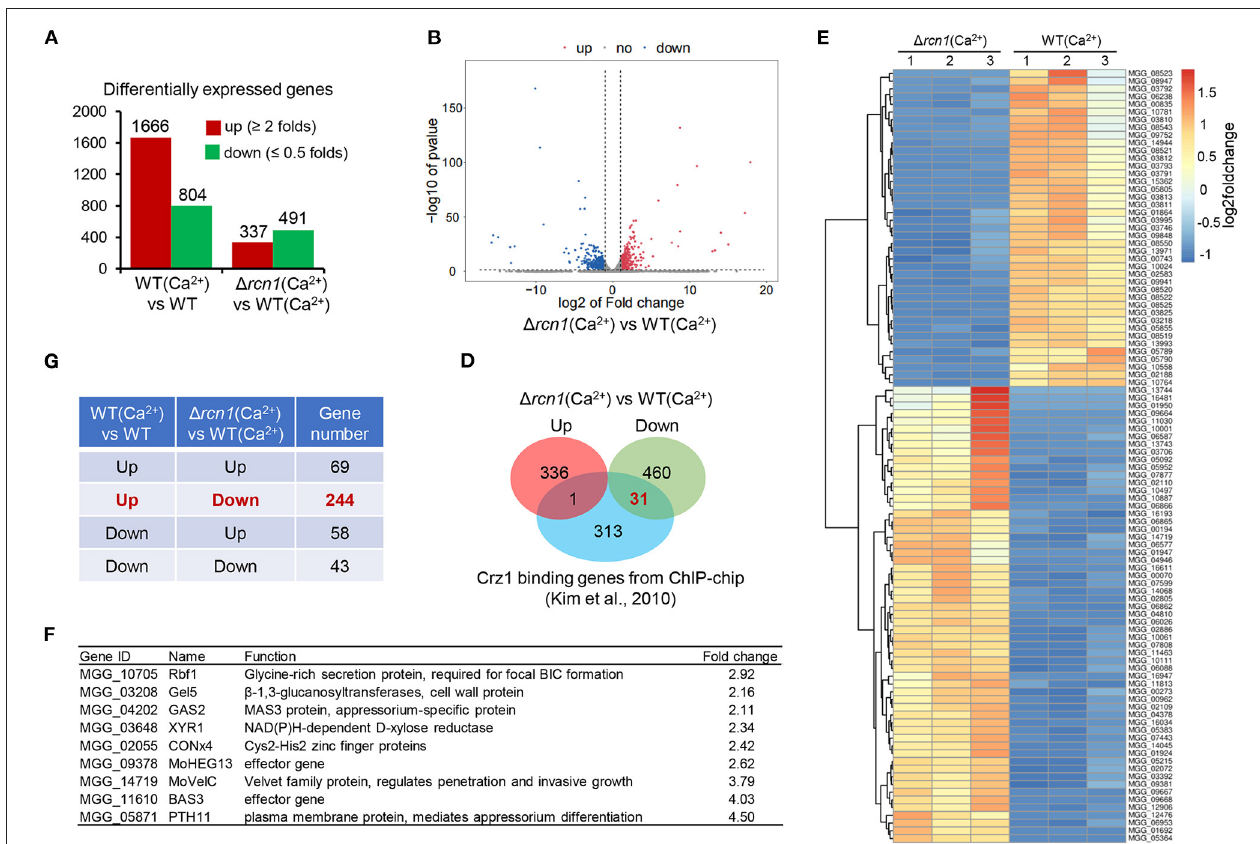
FIGURE 8 | Integrative analysis of RNA-seq genes affected by calcium in WT and 1 Morcn1 mutants. (A) Differentially expressed genes of different comparing pairs obtained from RNAseq data. (B) Expression fold changes of genes in 1 Morcn1 induced by Ca 2 + compared with WT induced by Ca 2 + (|log2[FC]| > 1; p -adj < 0.05). (C) Gene numbers shared in different comparing pairs of upregulated or downregulated genes in (A) . (D) Overlap of MoRCN1-regulated and Crz1-regulated genes reported by Kim et al. (2010). (E) Heatmap shows hierarchical clustering of genes from transcriptome data. WT (Ca 2 + ), the wild type strain induced by CaCl 2 ; 1 Morcn1 (Ca 2 + ), the 1 Morcn1 mutants induced by CaCl 1 Morcn1 (Ca 2 + ) compared 2 . (F) Previously reported pathogenesis genes in differentially expressed genes of with WT(Ca 2 +